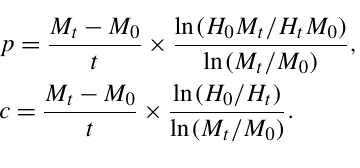
); amino acid con- 4